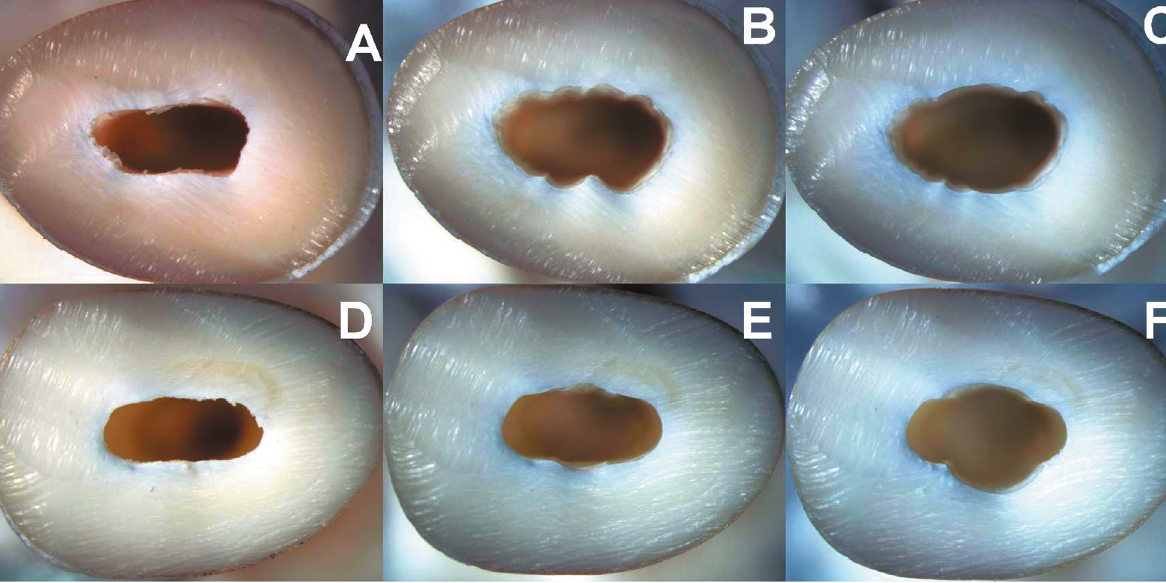
Figure 3- Photographs from stereomicroscopy (magnification 15x) of the root cervical third. Root canal before (A) and after (B) manual preparation; canal after prosthetic preparation (C). Root canal before (D) and after (E) rotary preparation; canal after prosthetic preparation (F)